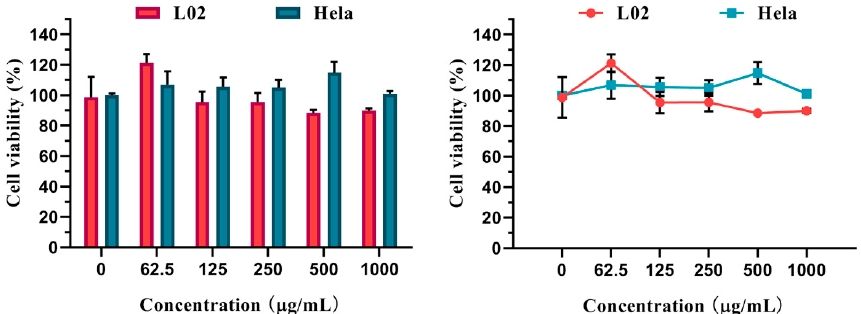
Figure 3. Cytotoxicity of different Ce-CDs-FA concentrations on L02 and Hela